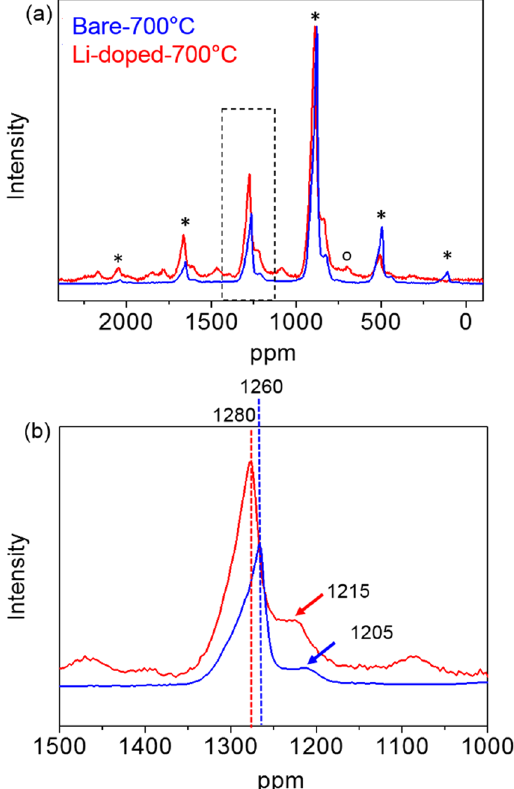
Figure 5. Comparison of 7 Li MAS NMR spectra in ( a ) the bare − 700 °C sample and the Li-doped − 700 °C sample and ( b ) the comparison of 7 Li MAS NMR spectra in lithium local environment in tetrahedral site in the two samples around 1200 ppm (asterisk * : sideband, circle( ο ): signal of Li 2 MnO 3